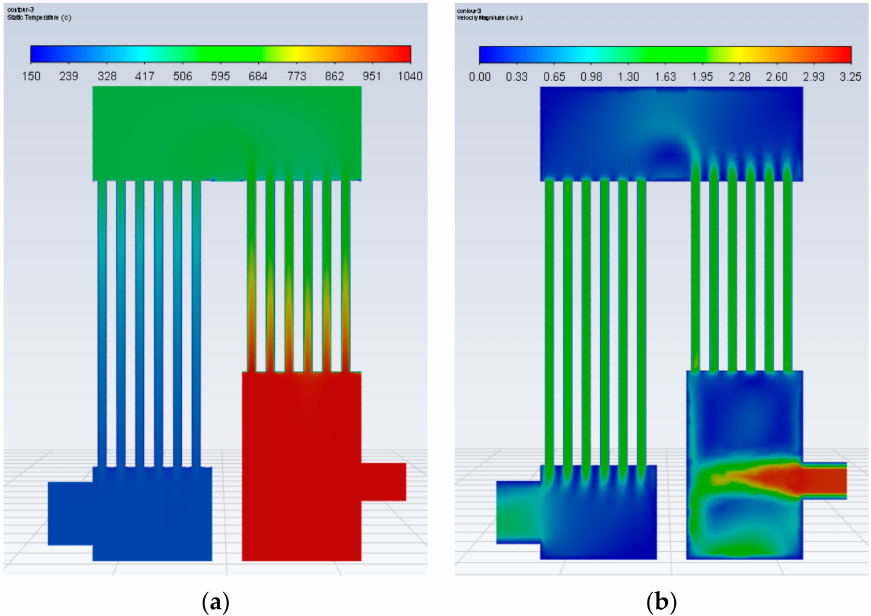
Figure 10. Temperature ( a ) and velocity ( b ) field of the designed boiler with constant inlet flow, with constant